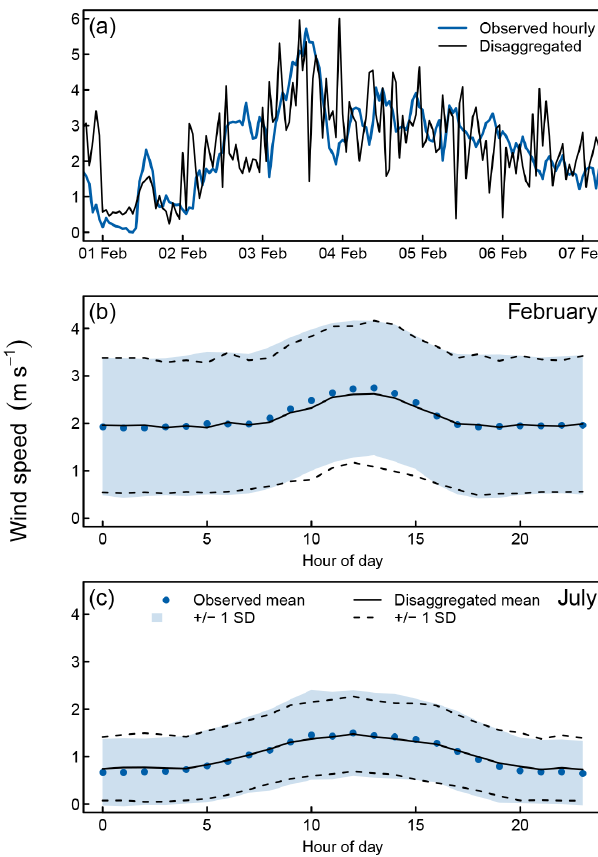
Figure 3. Comparison of disaggregated and observed sub-daily wind speeds at the Menz weather station (5km from Stechlin- see): sample of observed hourly wind data from 1998 and the dis- aggregated wind speeds generated from the corresponding daily means (a) ; hourly mean and standard deviation of observed (cir- cles, shaded area) and disaggregated wind speeds (solid and dashed lines) in February (b) and July (c) .